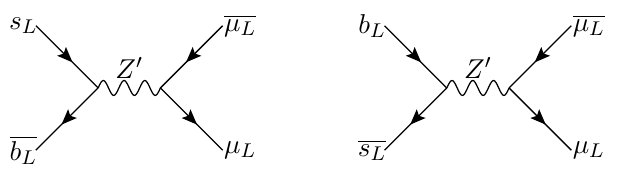
Figure 1 . Feynman diagrams of parton interactions in pp collisions where a (cid:13)avourful Z 0 pro- duces a (cid:22) + (cid:22) (cid:0) (cid:12)nal state. In the low momentum limit, the same diagrams generate an e(cid:11)ective operator capable of accounting for the discrepancies in B ! K ( (cid:3) ) (cid:22) + (cid:22) (cid:0) decays as compared to SM